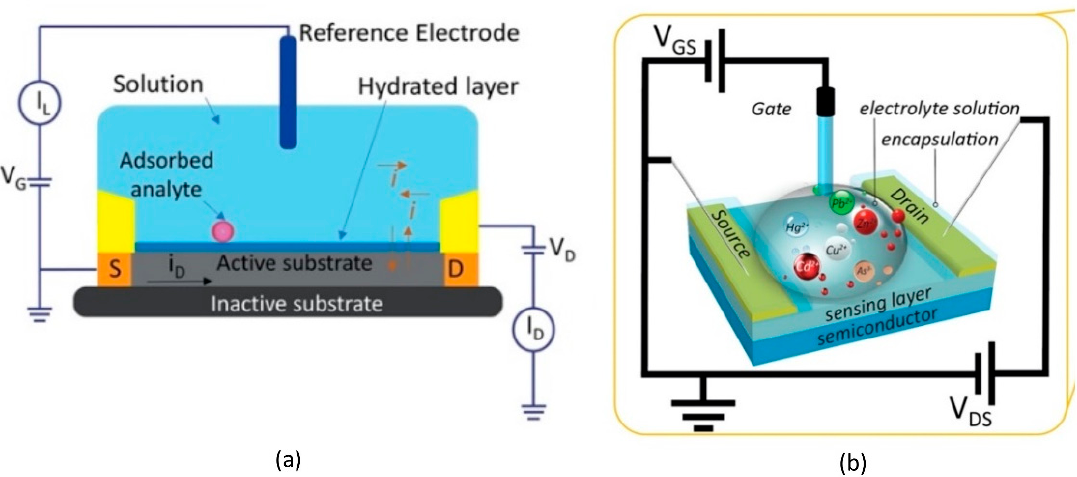
Figure 2. Illustration of ( a ) basic structure of electrolyte-gate and ( b ) three-dimensional image of HEMT biosensor. Reprinted from reference [93]. Copyright 2021, with permission from MDPI .